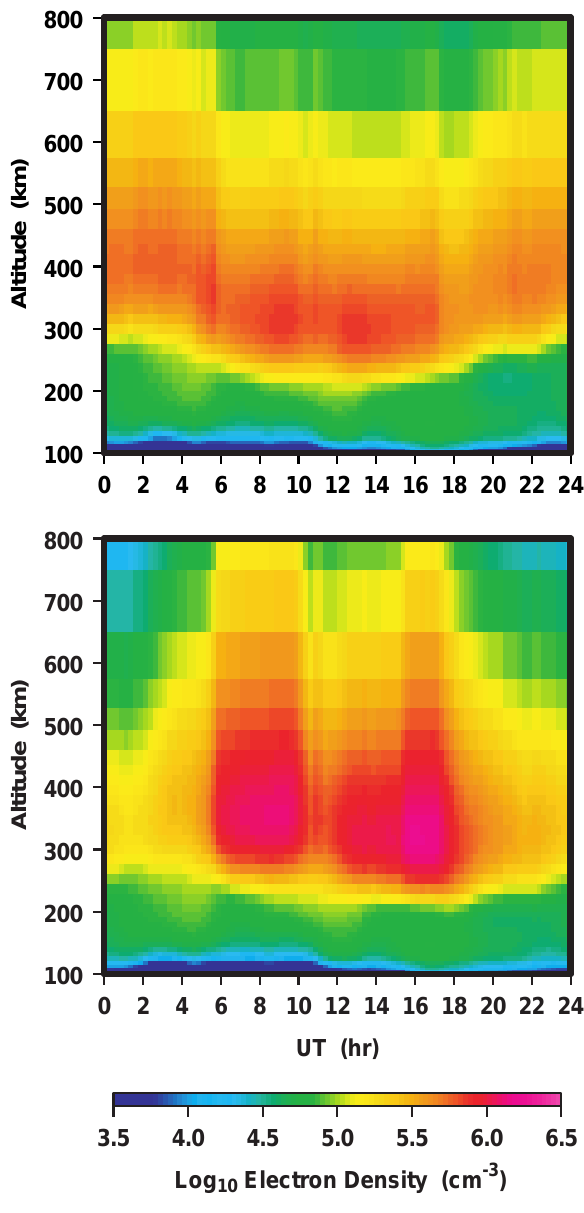
Fig. 2. TDIM simulations for the Longyearbyen location on 19 Oc- tober 2002, for the standard TDIM with HWM (top panel), and the TDIM with the neutral wind set to zero (bottom panel). N e is dis- played in the same format as in Fig.